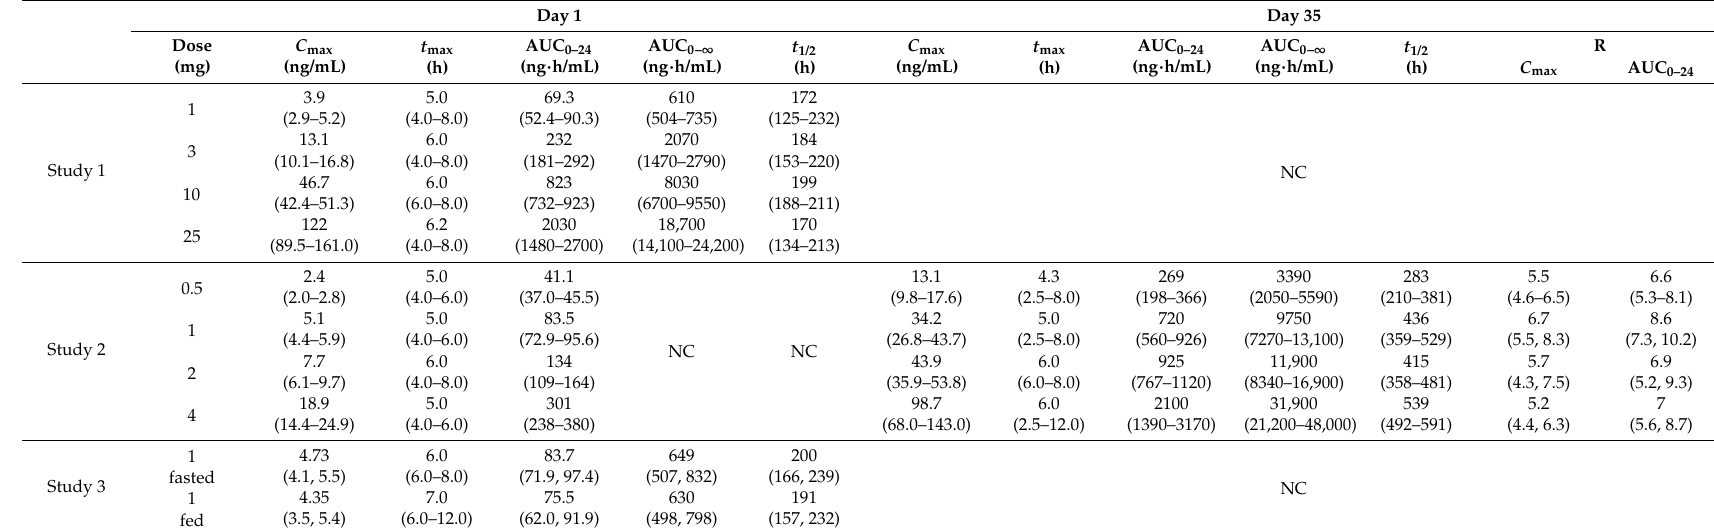
Table 1. Pharmacokinetic parameters of cenerimod estimated following single-dose (Study 1), o.d. for 35 days (Study 2), and single-dose administration in fed or fasted conditions (Study